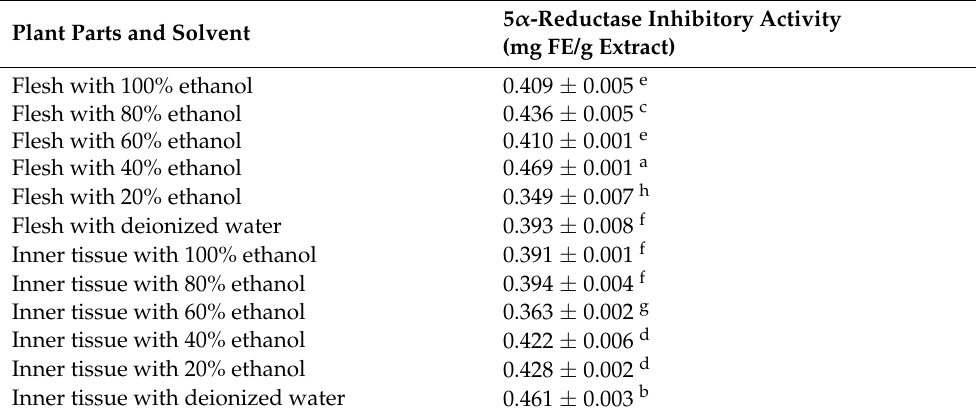
Table 4. The 5a-reductase inhibitory activity of M. charantia extracts.